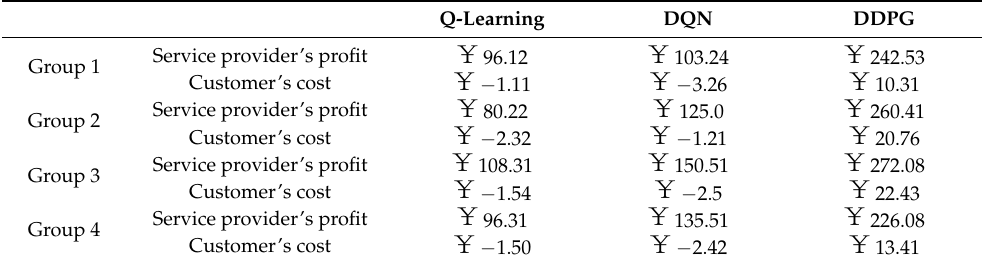
Figure 6. Training curve of optimal model.